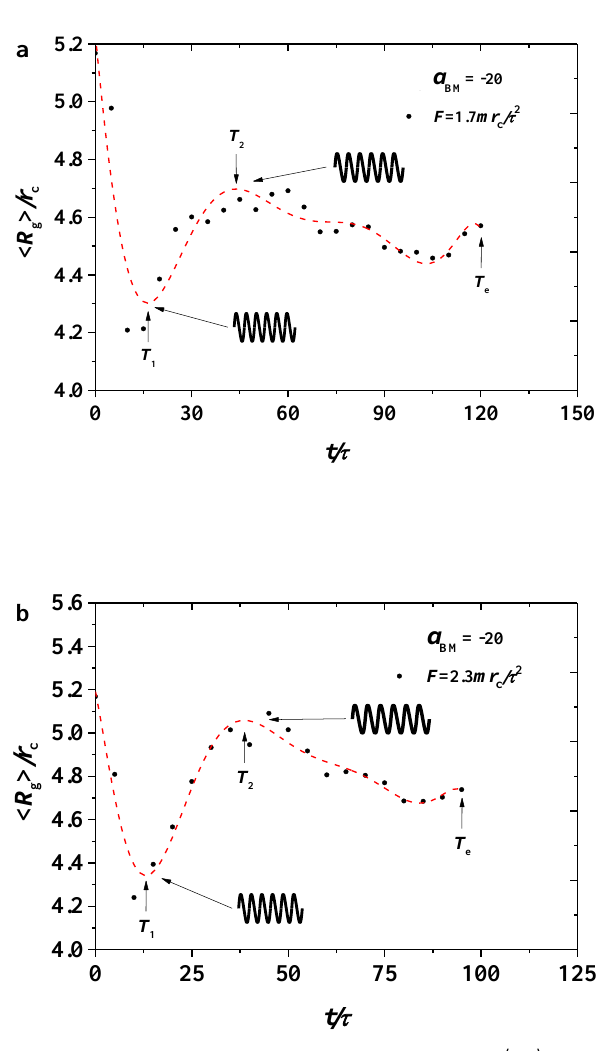
Figure 7. Variation of gyration radius for the bottlebrush polymers cases of a BM = − 20, where the red dotted lines indicate the fitting results with ( a ) the pulling force of F = 1.7 mr c / τ 2 and ( b ) the pulling force of F = 2.3 mr c / τ 2 , respectively.